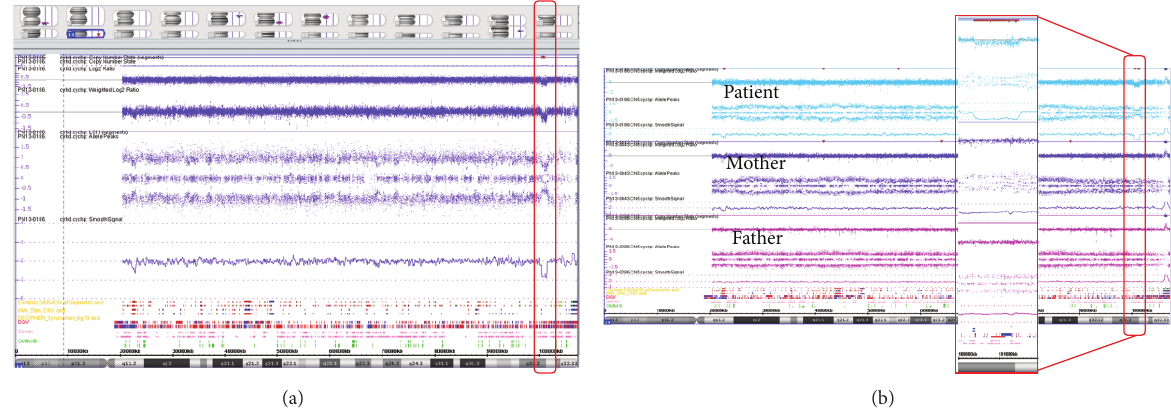
Figure 2: (a) Array plots of chromosome 14, visualized using the Affymetrix Chromosome Analysis Suite (ChAS) Software. A 1.1Mb loss in 14q32.2q32.31 was detected in Patient 1 (arr[hg19] 14q32.2q32.31(100,388,343-101,506,214)x1 dn) as indicated by the red rectangle. (b) Trio analysis confirms that the deletion has occurred de novo in the patient.